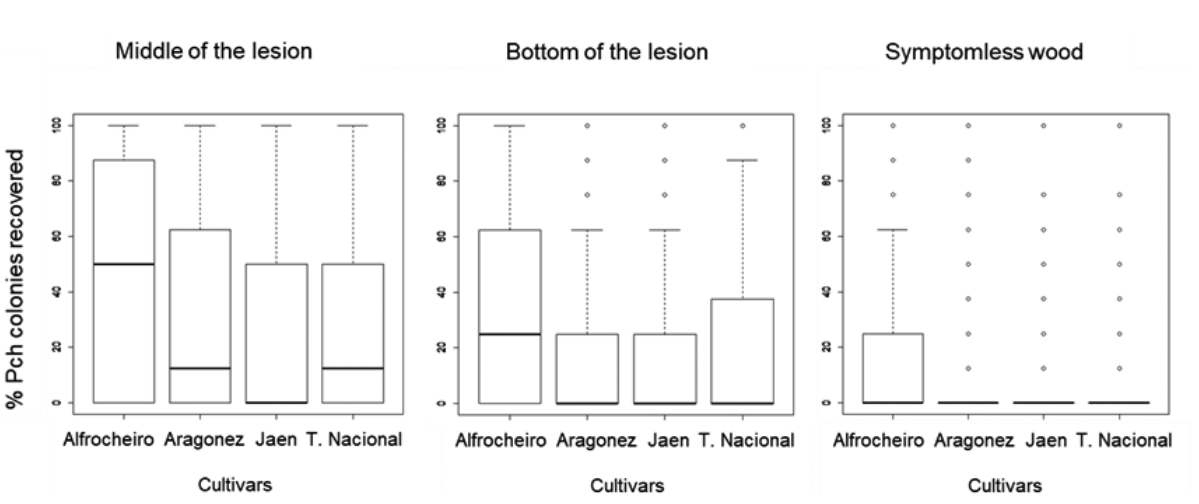
Figure 2. Boxplots of proportions (%) of Phaeomoniella chlamydospora colonies recovered from the middle of lesion, the bot - tom of the lesion or from symptomless wood, for the four grapevine cultivars. The median is represented by the solid